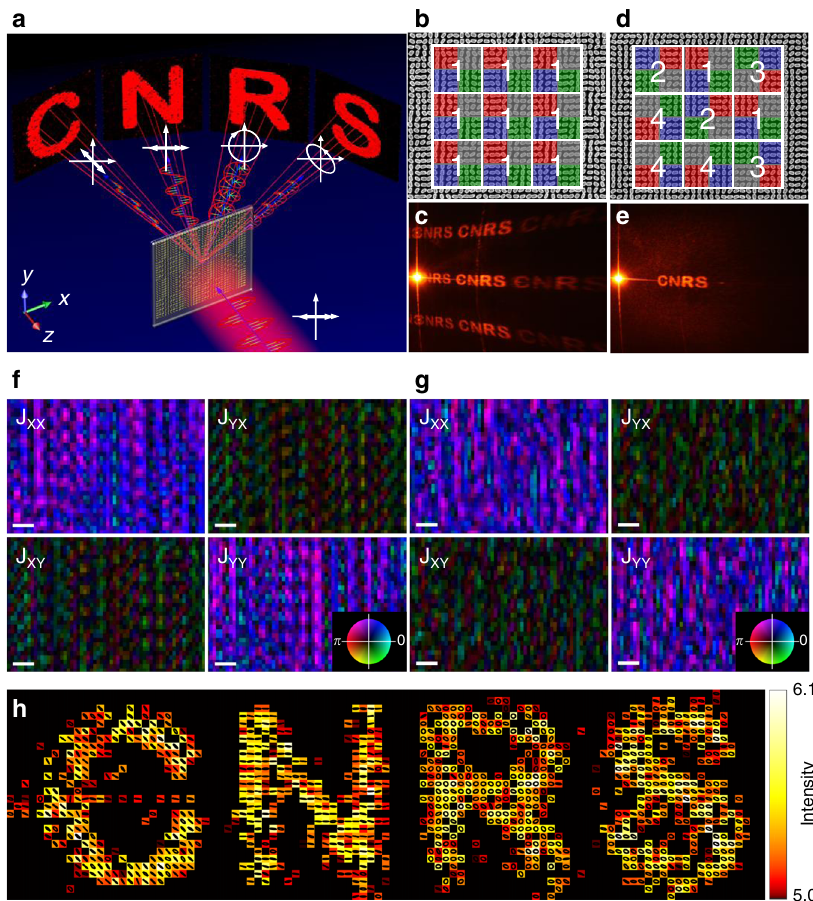
Fig. 4 Realization of polarization-reconstructed meta-hologram with four sub-polarization pixels. a Schematic of the polarization-reconstructed and multi-directional meta-hologram. b SEM image of the fabricated meta-hologram with uniformly distributed subpixels. c Photograph of the holographic image with a series of ghost images. d SEM image of the fabricated meta-hologram with randomly distributed subpixels. e Photograph of the holographic image with pure desired images. f Close-ups of Jones matrices maps of uniformly distributed and g randomly distributed meta-hologram, with phase encoded as hue and modulus encoded as brightness. Scale bars are 2.2 µ m. h Intensity values (arbitrary units), together with the corresponding SoP, of the reconstructed vectorial far fi eld of the